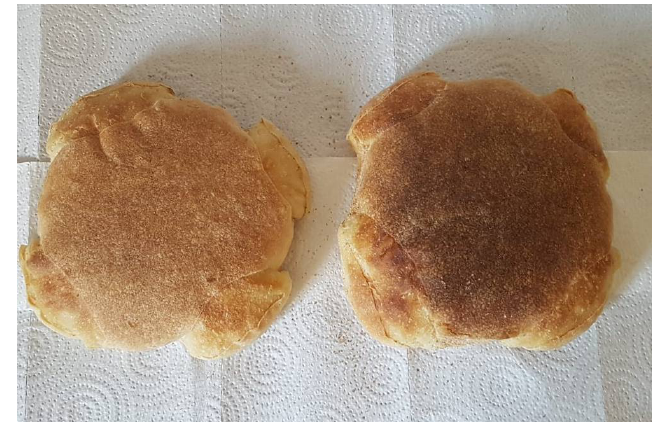
Figure 6 . Egyptian Shamsi bread. Figure 6. Egyptian Shamsi 3.5. Baking